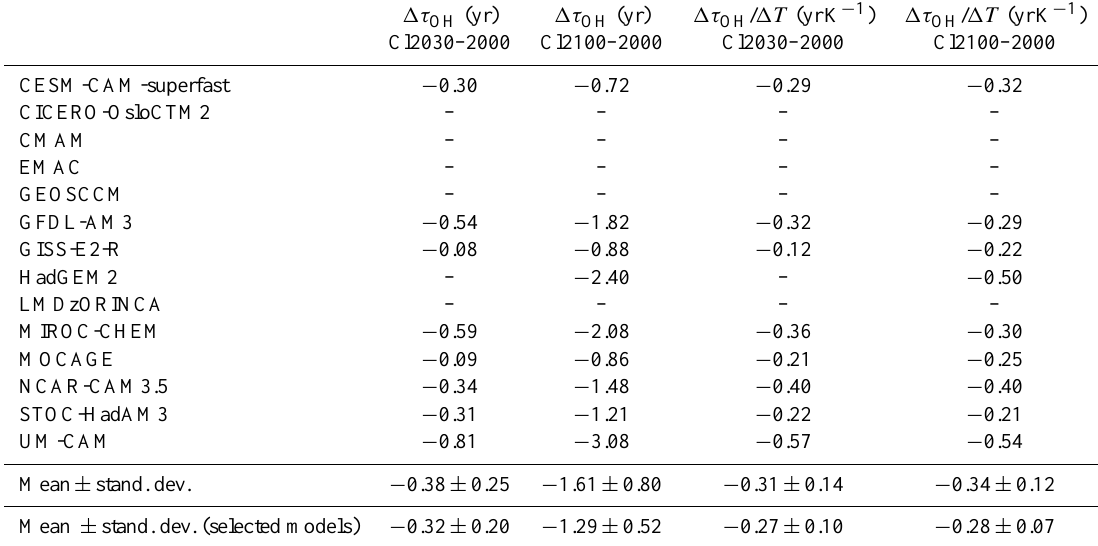
Table 4. Global tropospheric chemical methane lifetime change in the climate change sensitivity simulations, and lifetime change per unit change of global temperature (or “climate penalty factor”), for the different ACCMIP models. The multi-model mean and standard deviation are also shown. The last row shows the means and standard deviations using a subset of models, excluding HadGEM2 and UM-CAM. 1τ OH (yr) 1τ OH (yr)